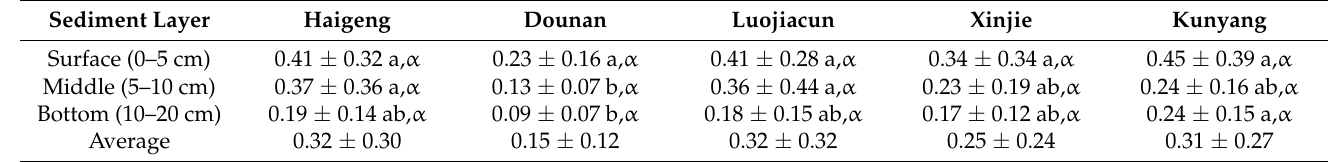
Values (means ± standard deviation, n = 12 for a year) followed by different letters indicate significant differences p < 0.05 (one-way analysis of variance) among different sediment sampling sites for the same sediment